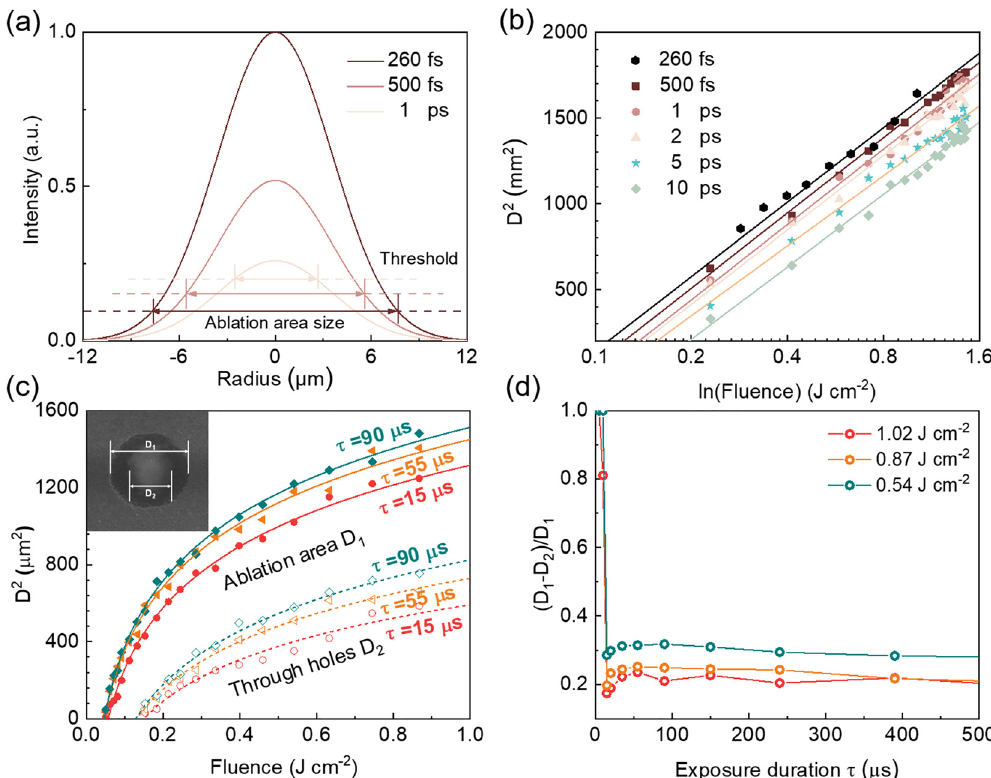
Figure 2: The laser processing parameters of perovskite. (a) The energy intensity distribution of the laser focal plane with different pulse widths. (b) Plot of squared diameter D 2 of ablated area with respectto fl uenceforpulsewidths d =260fs,500fs,1ps,2ps,5psand10ps.(c)Squareddiameter D 2 oftheablationarea(solidmarkers)and thethroughhole(hollowmarkers)producedinthe550nmthickperovskite fi lmunderexposureduration τ =15µs,55µs,90µs(referringtothe scanning speed v = w 0 / τ , 1.67 m/s, 0.45 m/s, 0.28 m/s respectively) irradiation versus applied fl uence F according to Eq. (1). (d) The relationships between ( D 1 − D 2 )/ D 1 and laser exposure duration under different laser fl uence. The pulse duration is 260 fs in (c) and